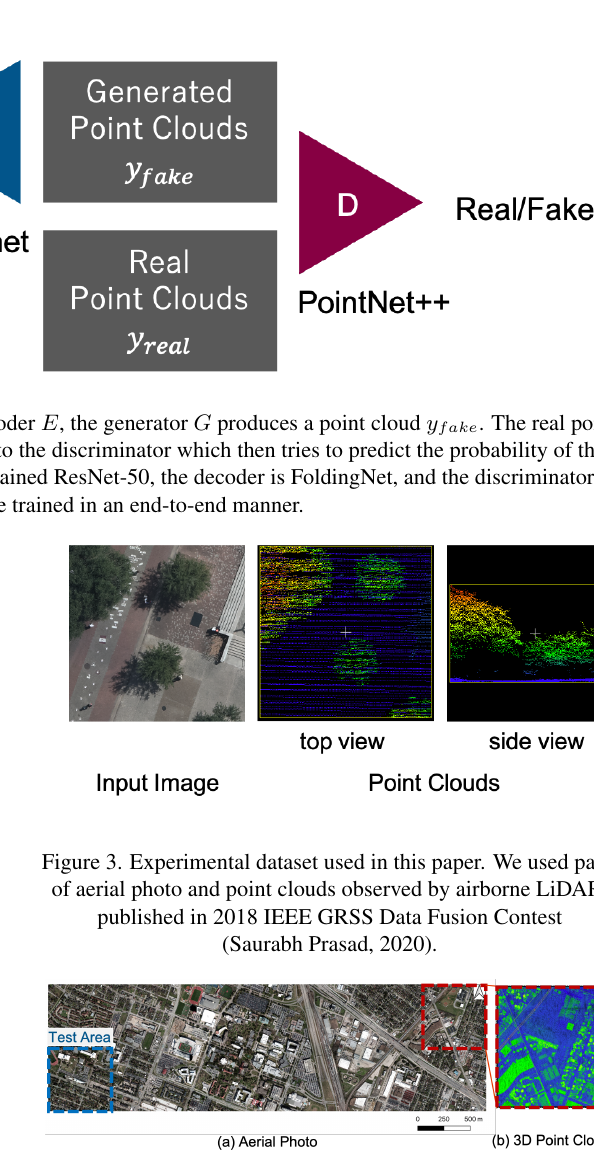
Figure 4. Target area used in this paper. The data are published in the 2018 IEEE GRSS Data Fusion Contest (Saurabh Prasad,